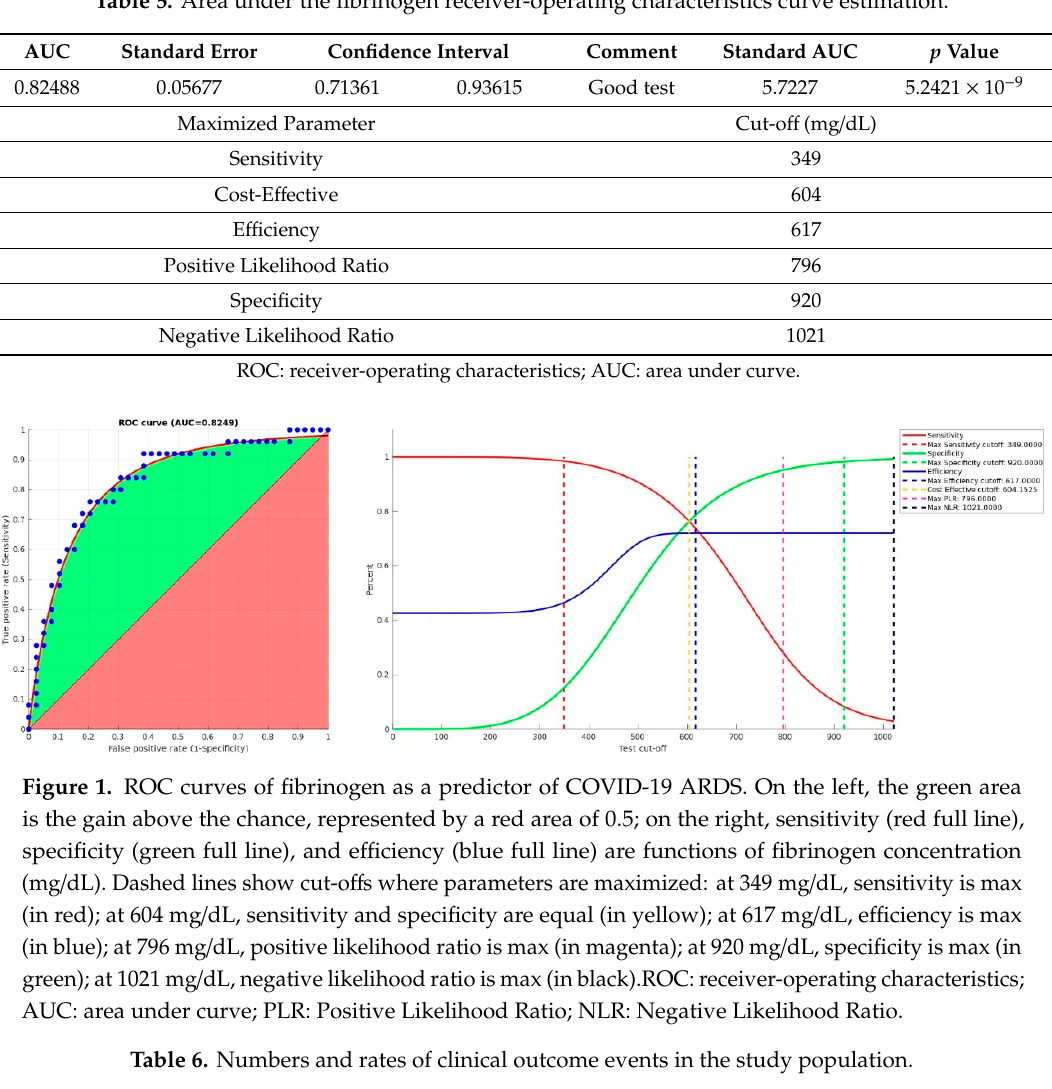
Table 5. Area under the fibrinogen receiver-operating characteristics curve estimation.